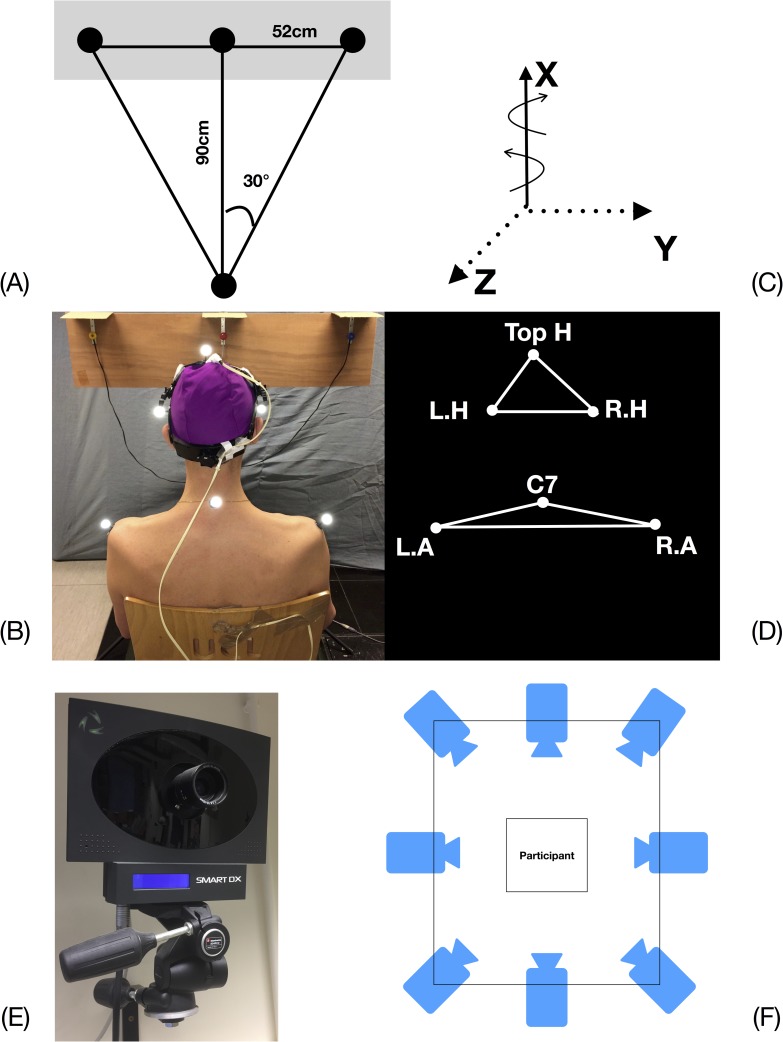
DidRen Laser, kinematic model and instrumentation.(A) DidRen Laser installation device including the 3 photosensitive sensors. (B) The placement of markers on the helmet (Head = H, Left Head = L.H, Right Head = R.H) and the shoulders (Left Acromion = L.A, Right Acromion = R.A, 7th Cervical vertebrae = C7). (C) Head rotation is executed around a vertical axis (X) in a horizontal plane (Y-Z). (D) Segments modeled as two triangles with reflective markers on the head and the trunk. (E) One infra-red camera. (F) Representation of the field of vision of the infra-red cameras.